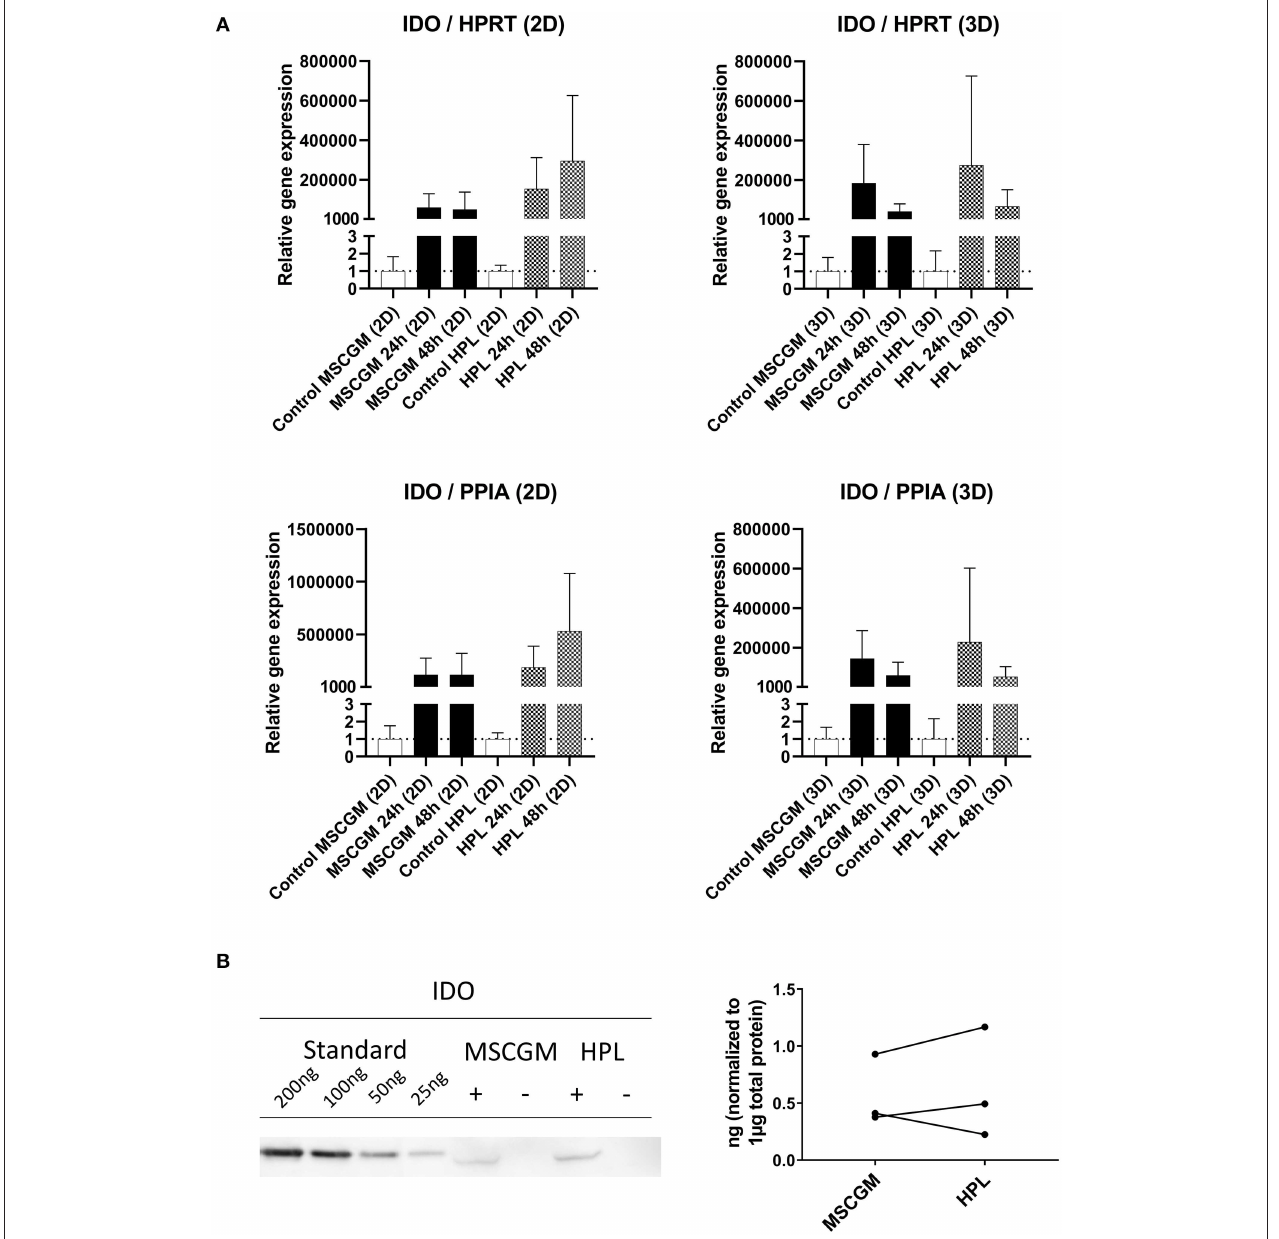
FIGURE 5 | Expression of the immunological molecule IDO. (A) RT-PCR analysis of IDO gene expression in 2D and 3D MSCs for 24 and 48h stimulation with IFN- γ /TNF- α cultured in MSCGM TM or MSCBM TM with 8% HPL and a control with unstimulated cells. Top: Relative gene expression levels of IDO normalized to the housekeeping gene HPRT. Bottom: Normalized to the housekeeping gene PPIA (2D n = 5; 3D n = 3). (B) Left: Western blot analysis of IDO protein expression stimulated with IFN- γ /TNF- α ( + ) or unstimulated (–) after 48h. An internal standard of IDO ranging from 25 to 200 ng was included. One representative blot of three independent experiments is shown. Right: Comparison of IDO protein expression in ng per 1 µ g total protein of three IFN- γ /TNF- α stimulated